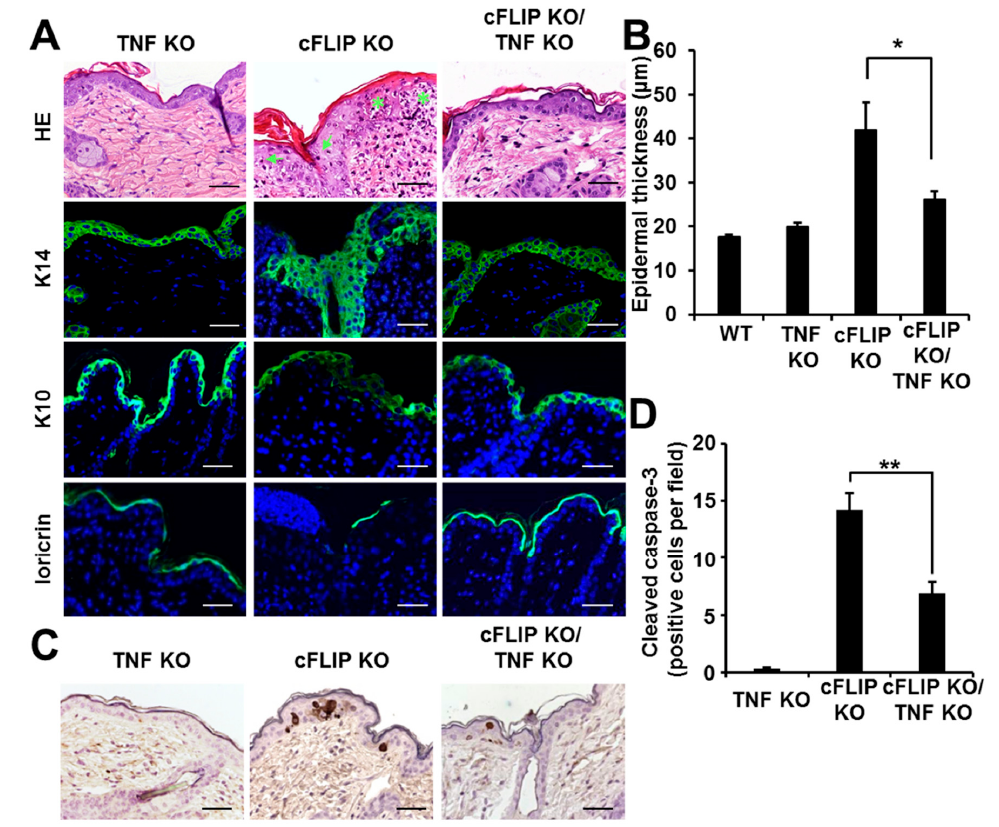
Figure 2. TNF signaling is required for epidermal hyperplasia upon acute loss of cFLIP and is critical for epidermal apoptosis in the absence of cFLIP. ( A ). Skin sections at T72H from TNF KO, cFLIP KO, and cFLIP KO/TNF KO animals stained with hematoxylin and eosin staining (H&E), keratin 14, keratin 10, and loricrin. Arrows: pyknotic nuclei; stars: intraepidermal pustules. Scale bars represent 50 µm. Blue: DAPI; green: K14 or K10 staining, respectively. ( B ). Epidermal thickness of skin isolated at T72H from TNF KO, cFLIP KO, and cFLIP/TNF KO mice, compared to skin isolated from wild-type mice (5–6 animals per group). ( C ). Skin section collected at T72H and stained with H&E along with an antibody against cleaved caspase-3 (brown) . Scale bars represent 50 µm. ( D ). Quantification of the cleaved caspase-3-positive cells per microscopic field; * p < 0.05; ** p < 0.01.